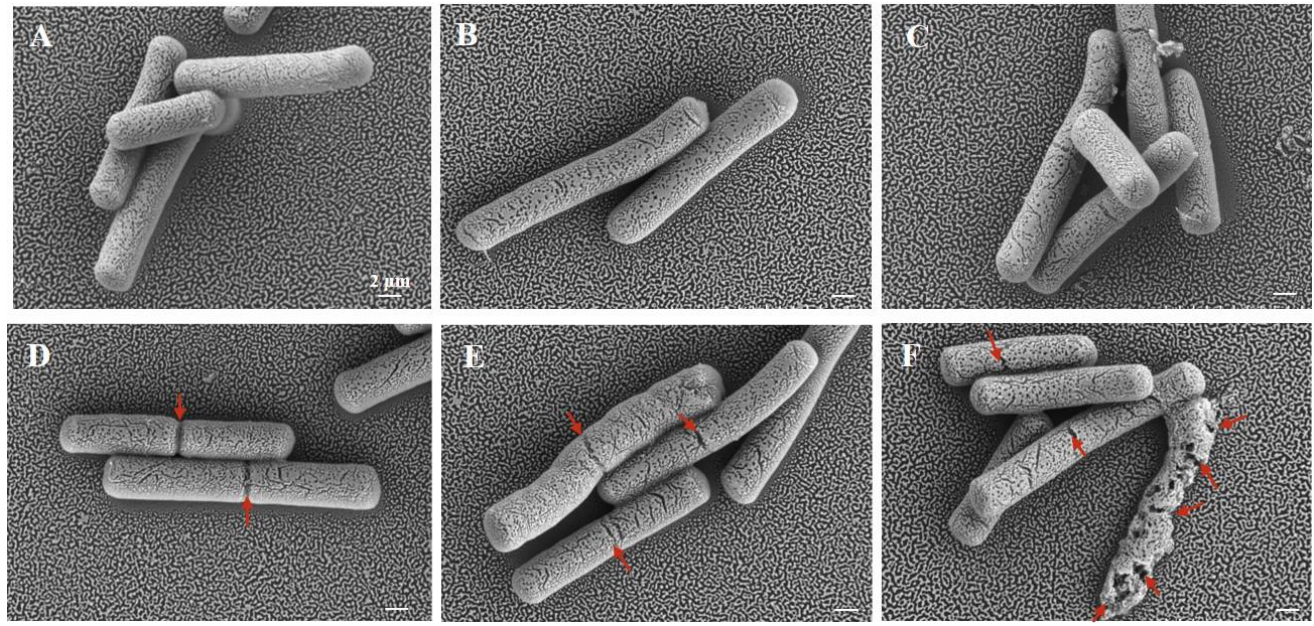
Figure 3. Scanning electron microscope image of B. subtilis after PDT treatment. ( A ) Untreated group; ( B ) single LED light group; ( C ) single 50 μmol/L curcumin group; ( D ) The treatment with 10 μmol/L curcumin for the illumination time of 12 min; ( E ) The treatment with 30 μmol/L curcumin for the illumination time of 12 min; ( F ) The treatment with 50 μmol/L curcumin for the illumination time of 12 min. The scale bar in the panel is 2 microns and all panels have the same magnification.